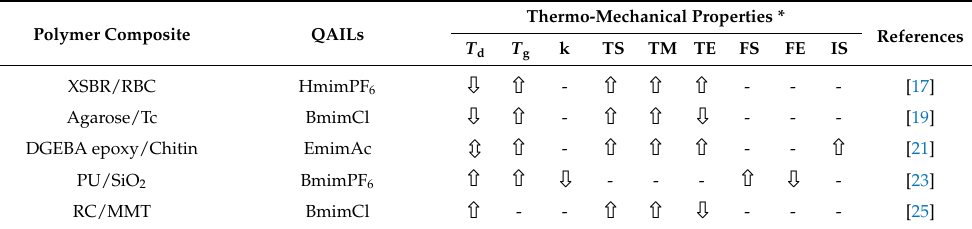
Table 7. Thermo-mechanical properties of polymer blends influenced by QASs and QAILs.